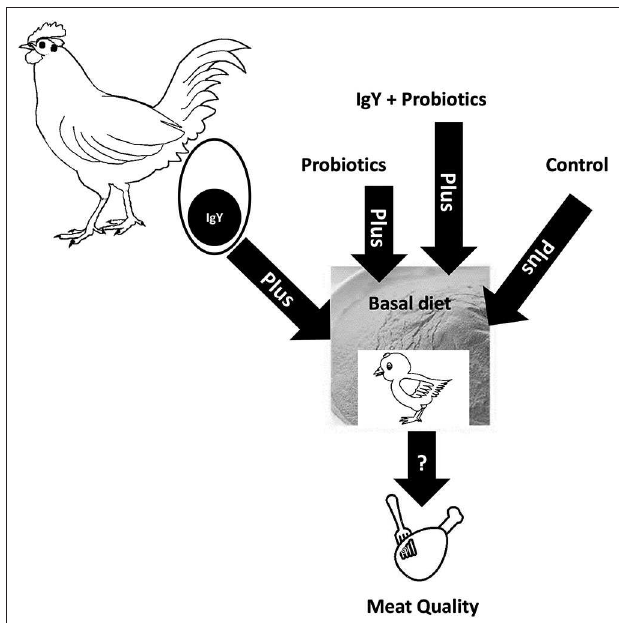
FIGURE 1 | Schematic cartoon of the experimental strategy.